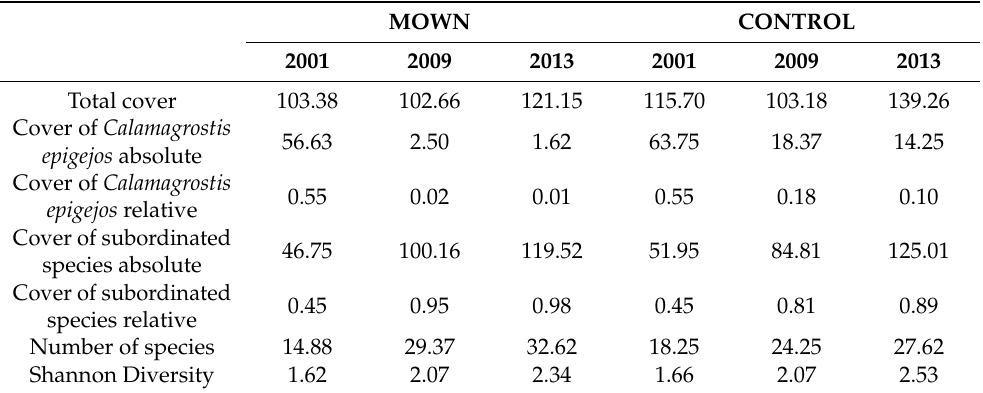
Table 1. The average cover of Calamagrostis epigejos and other species, number of species, and different diversity indices ( p <